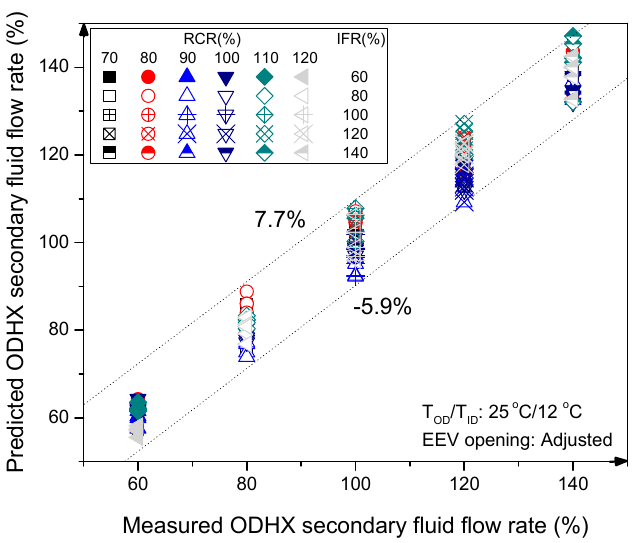
Figure 13. Error threshold of outdoor heat exchanger secondary fluid flow rate for simultaneous refrigerant charge fault, indoor heat exchanger flow rate fault and outdoor heat exchanger flow rate fault.